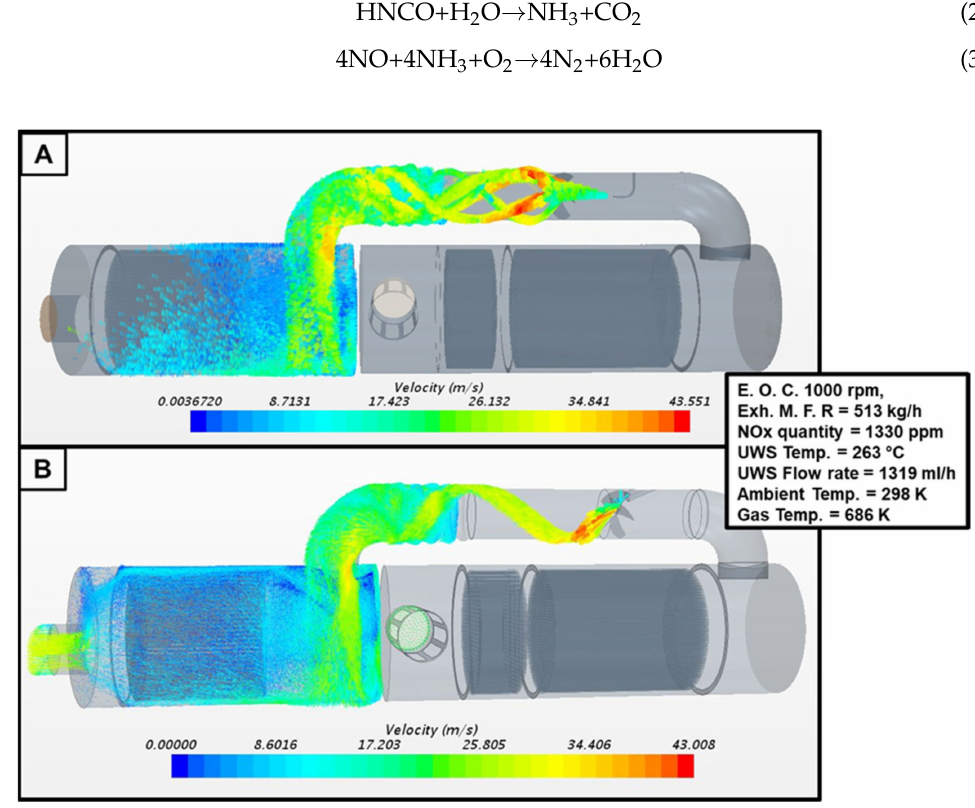
Figure 5. The pattern value of urea: ( A ) original urea injector; ( B ) suggested urea injector for Hyundai D6CC.